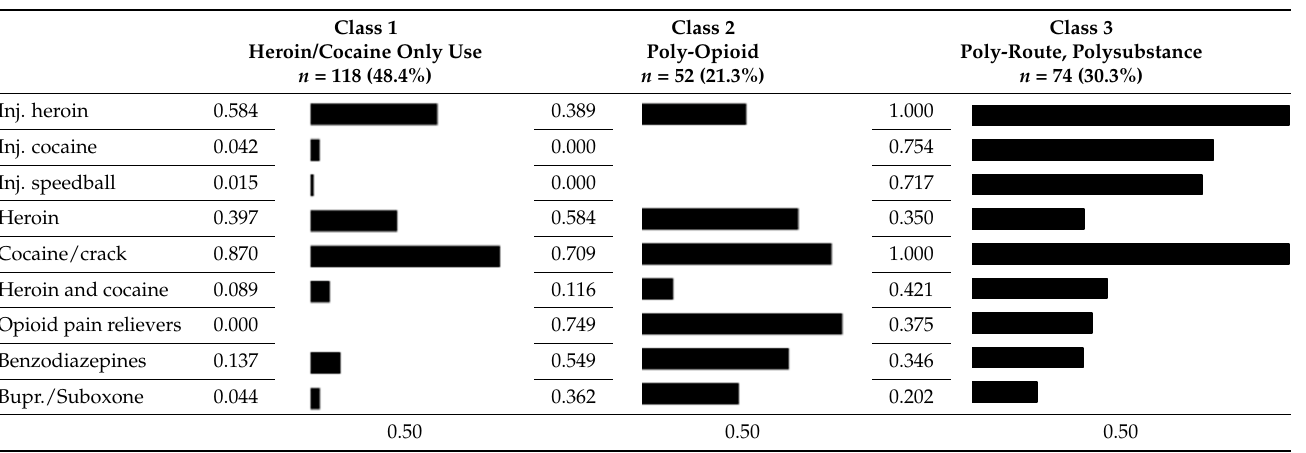
Table 3. Item–response probabilities of drug use indicators in each latent class among cisgender women ( n = 244).